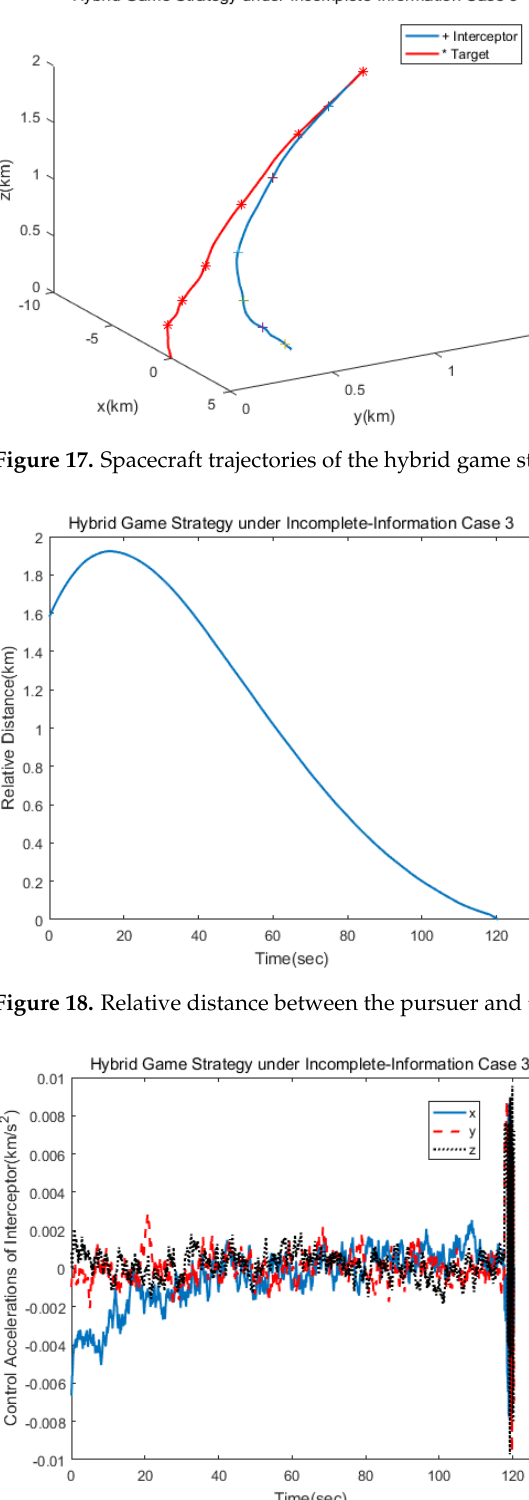
Figure 20. Control acceleration of the target. Figure 21. Error estimation of